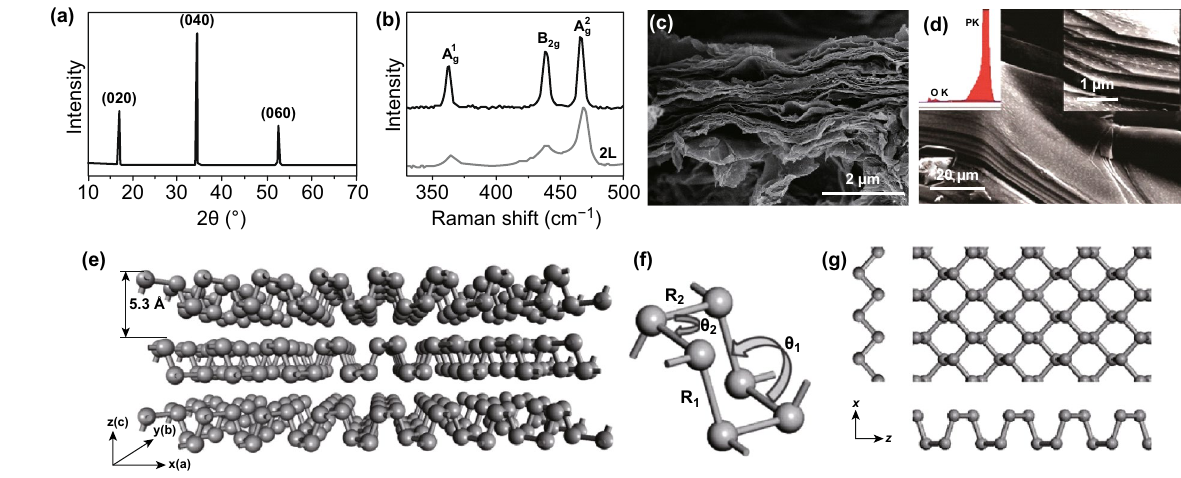
Fig. 4 a XRD [77] and b Raman spectra [78] of BP. SEM image of the layered structure of c graphene and d BP. e Crystal structure and f detailed structure parameter (bond length and bond angle) of BP [79]. g The top view of BP crystal structure [78]. Adapted from Refs. [77–79] with